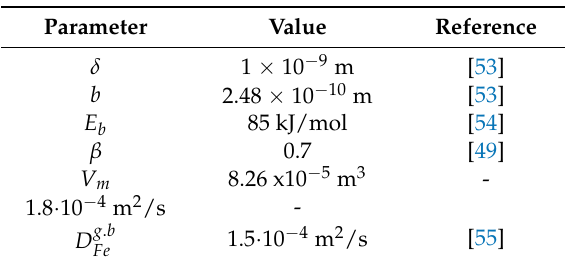
Table 7. Values of parameters used in the